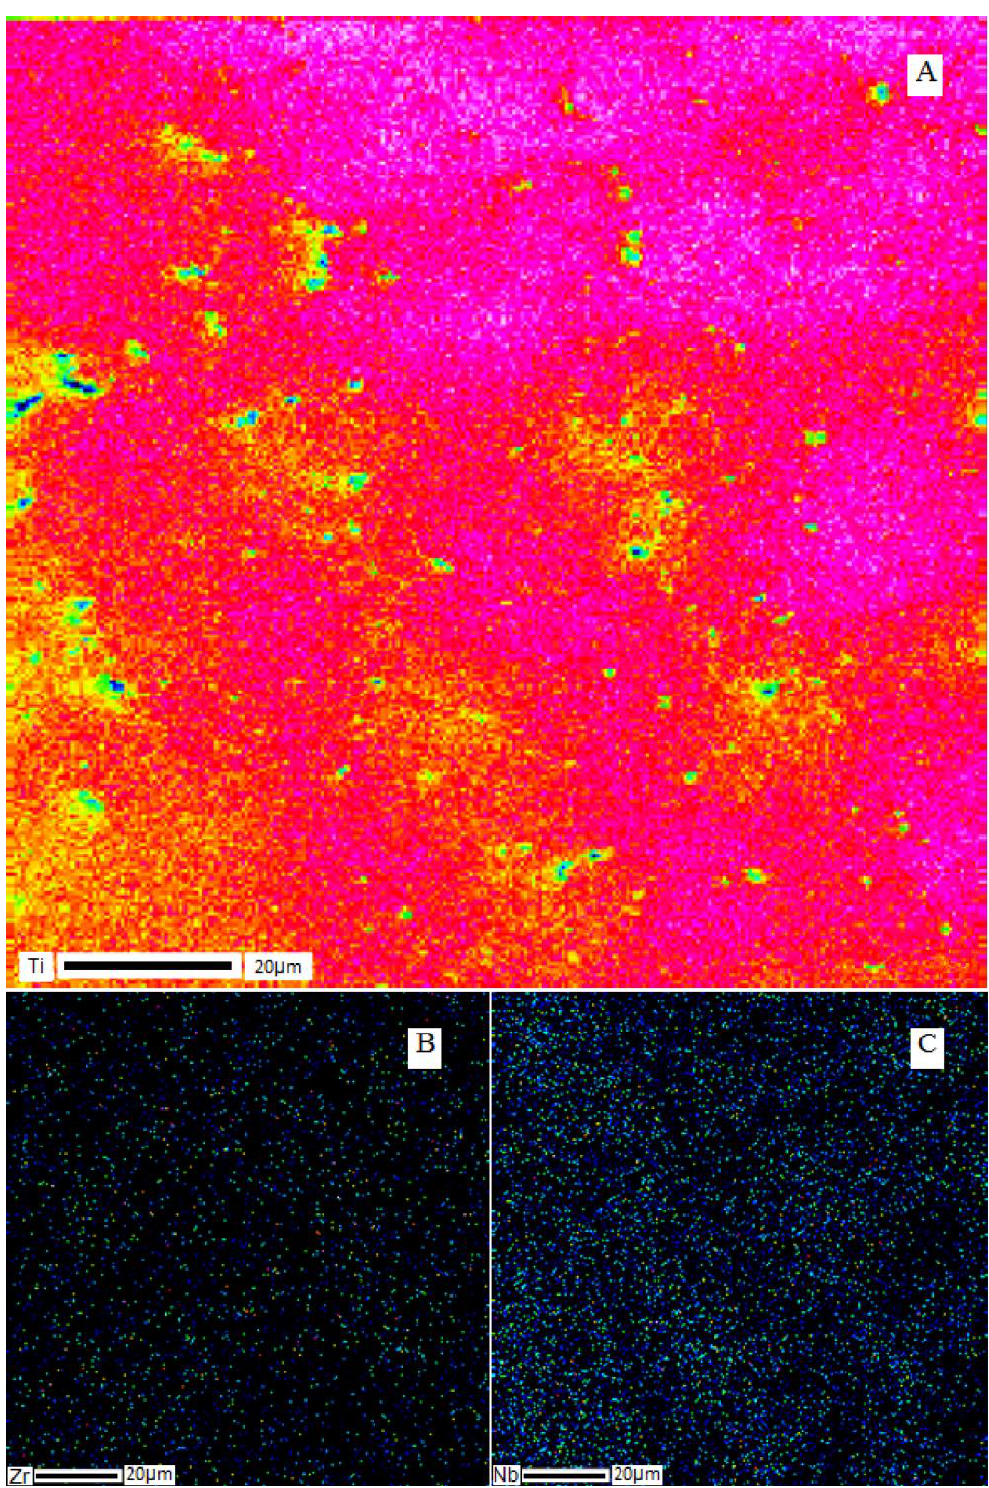
Figure 2. Elemental distribution of metals in the dendritic structure of the Ti–28Nb–5Zr alloy: ( A ) titanium; ( B ) zirconium; ( C ) niobium.